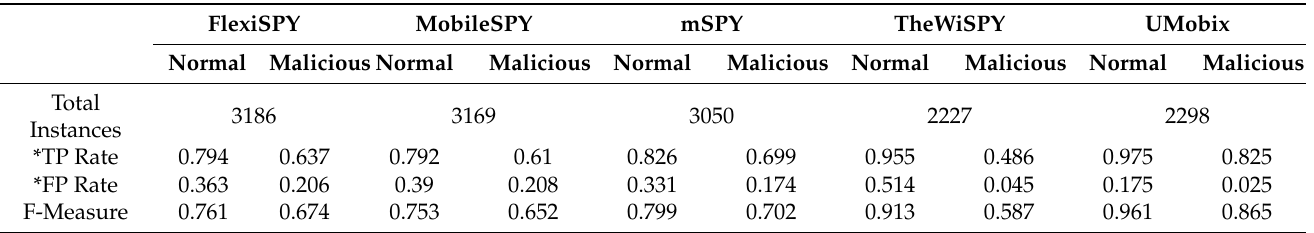
Table 13. Detailed accuracy